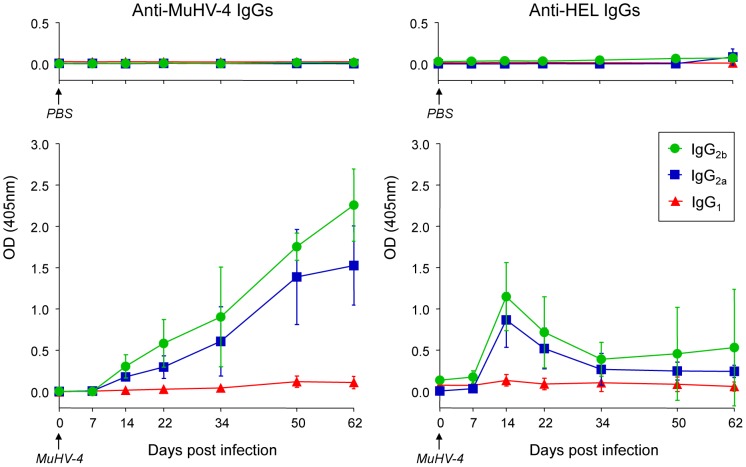
SWHEL mice mount a long-lasting anti-MuHV-4 antibody response.SWHEL mice were inoculated intranasally with PBS (n = 2) or MuHV-4 (n = 6). At indicated time points, mice were bled and sera were analyzed by ELISA to monitor levels of circulating anti-MuHV-4 and anti-HEL IgG1 (red triangles), IgG2a (blue squares) and IgG2b (green circles). For MuHV-4 infected mice, 3 independent experiments with 2 mice in each were analyzed. As no standard were available to quantify these antibodies, samples of different time points from identical mice were run together to be able to compare the absorbance at 405 nm.